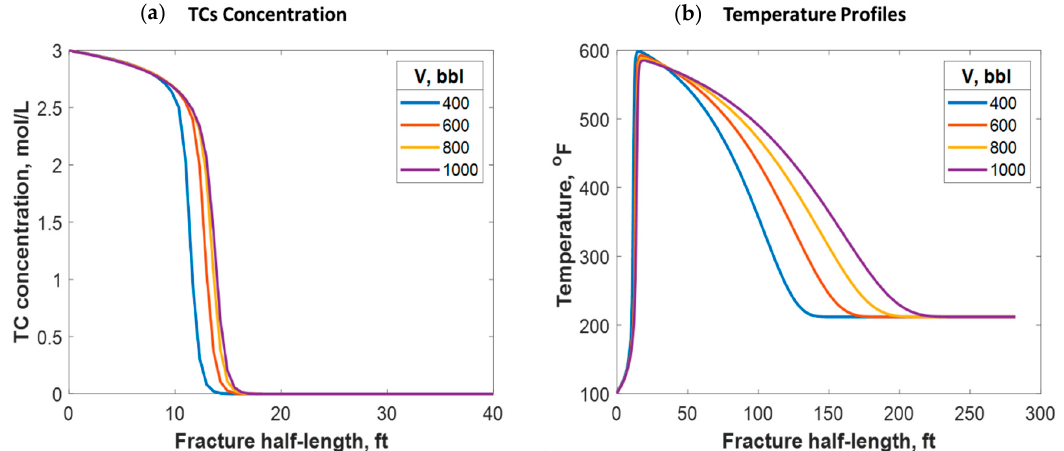
Figure 16. ( a ) TC concentrations and ( b ) fluid temperature profiles along the fracture half-length at different treatment volumes.